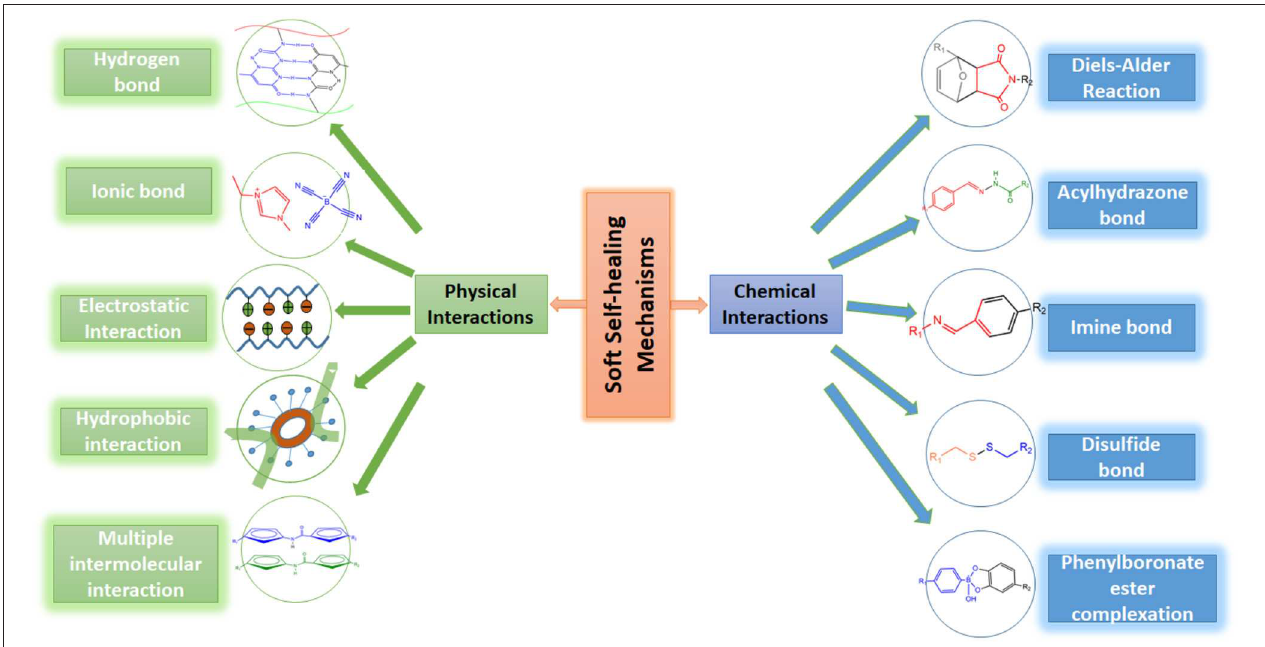
FIGURE 1 | Various strategies used to synthesize physical and chemical interaction based soft self-healing